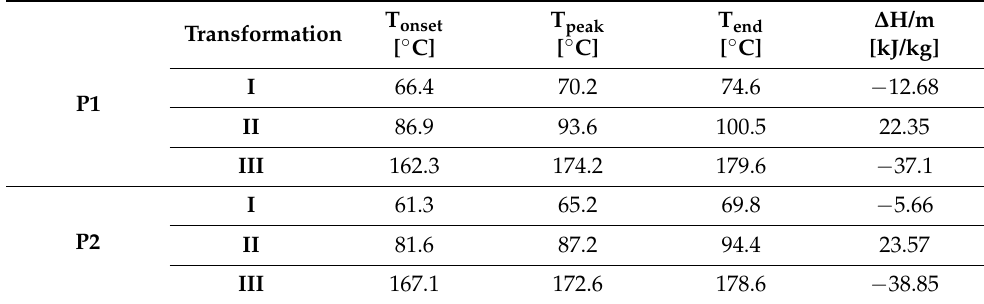
Table 2. Summary of data evaluation using Proteus software for calorimetrically characterized samples.